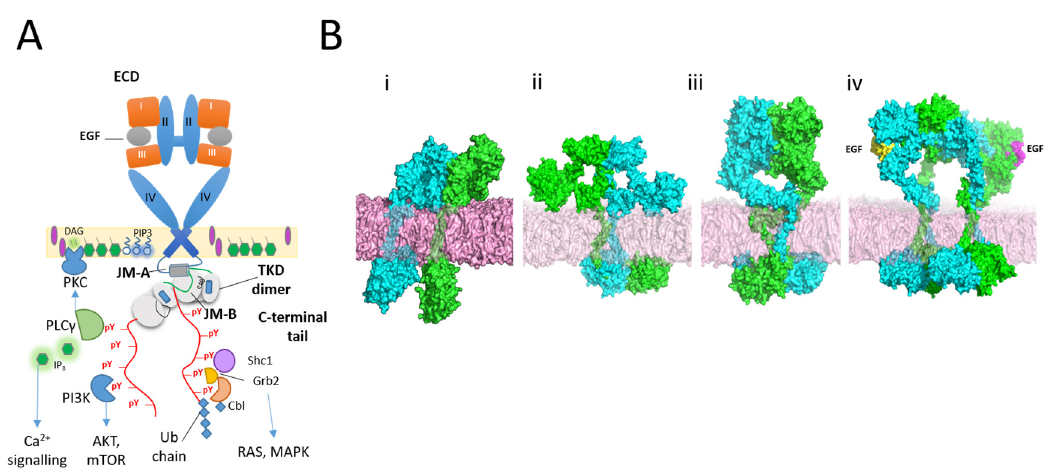
Figure 1. ( A ) Cartoon of EGF-bound EGFR dimer showing the extracellular back-to-back dimer [16,17] and the intracellular asymmetric tyrosine kinase dimer [18]. The latter leads to phosphorylation of C-terminal tyrosines and recruitment of effectors; ( B ) (i–iii) Ligand-free head-to-head, stalk-to-stalk and back-to-back dimers [5]. (iv) Ligand-bound tetramer. The open-ended scheme allows the formation of longer oligomers [4].